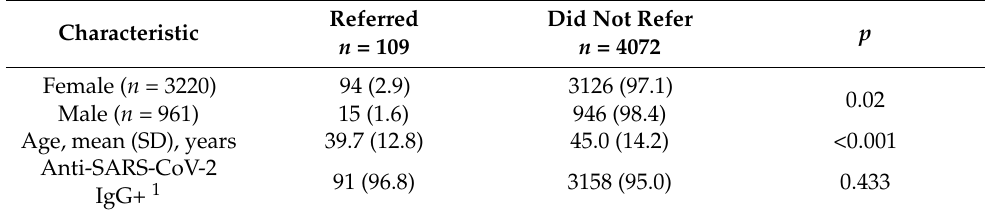
Table 4. Characteristics of participants who referred or did not refer to a healthcare institution due to adverse